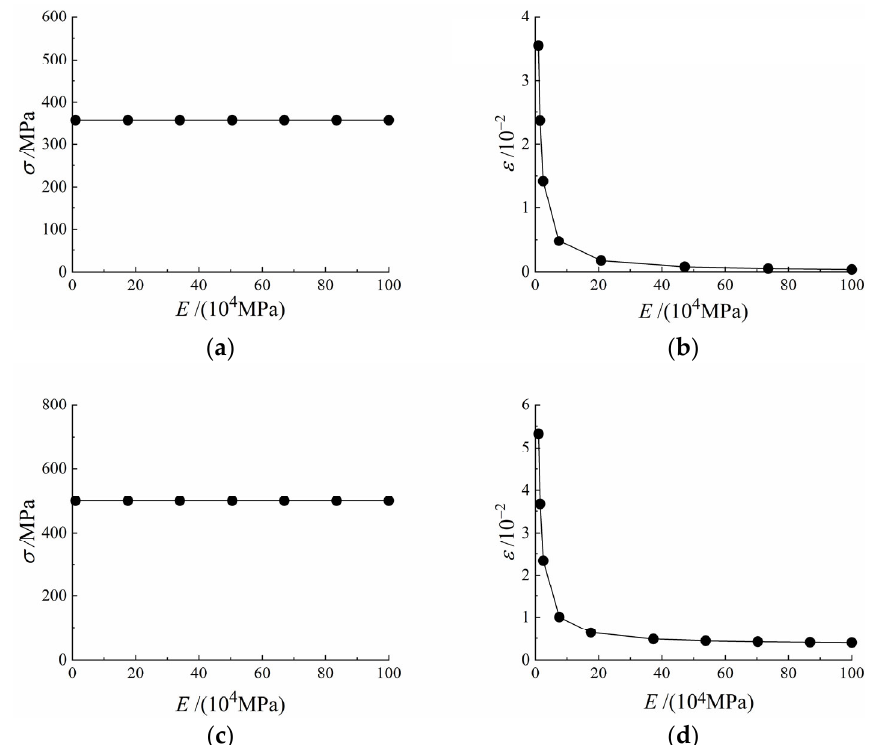
Figure 5. Influence law of E on stress and strain: ( a ) influence law of elastic stage E on stress; ( b ) influence law of elastic stage E on strain; ( c ) influence law of plastic stage E on stress; ( d ) influence law of plastic stage E on strain.